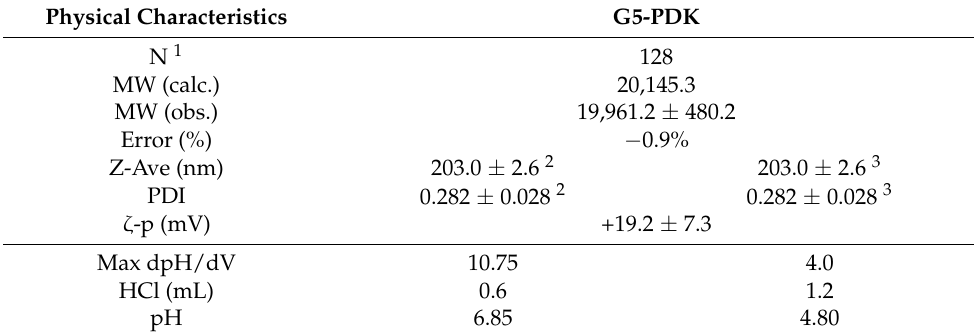
Table 1. Main physical features of G5-PDK.